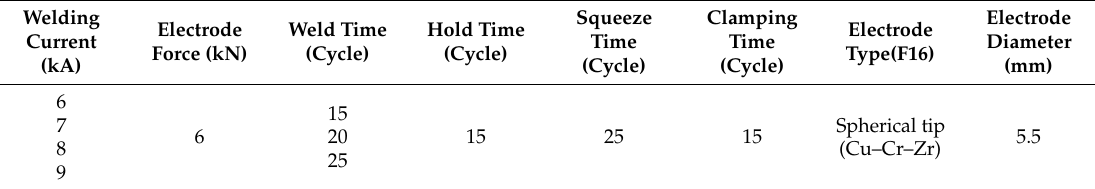
Table 2. Welding parameters.